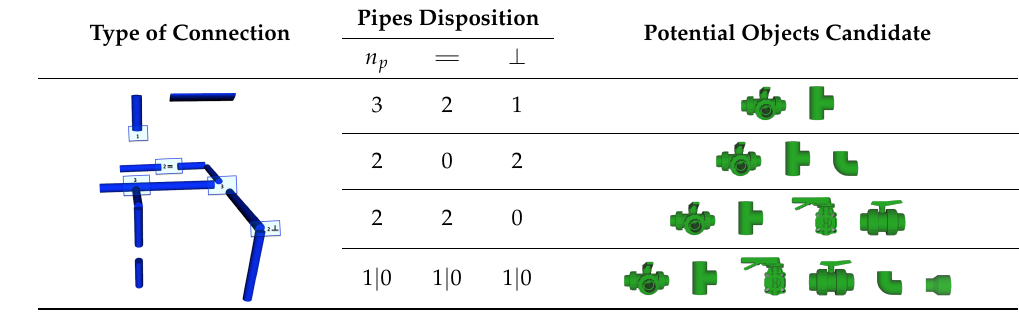
Table 4. Semantic connection of